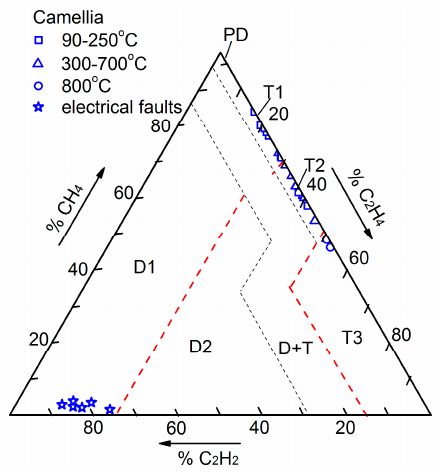
Figure 21. Diagnostic results of thermal and electrical faults of camellia oil based on the modified Duval Triangle 3 (data in the figure are expressed as a function of oven temperature).